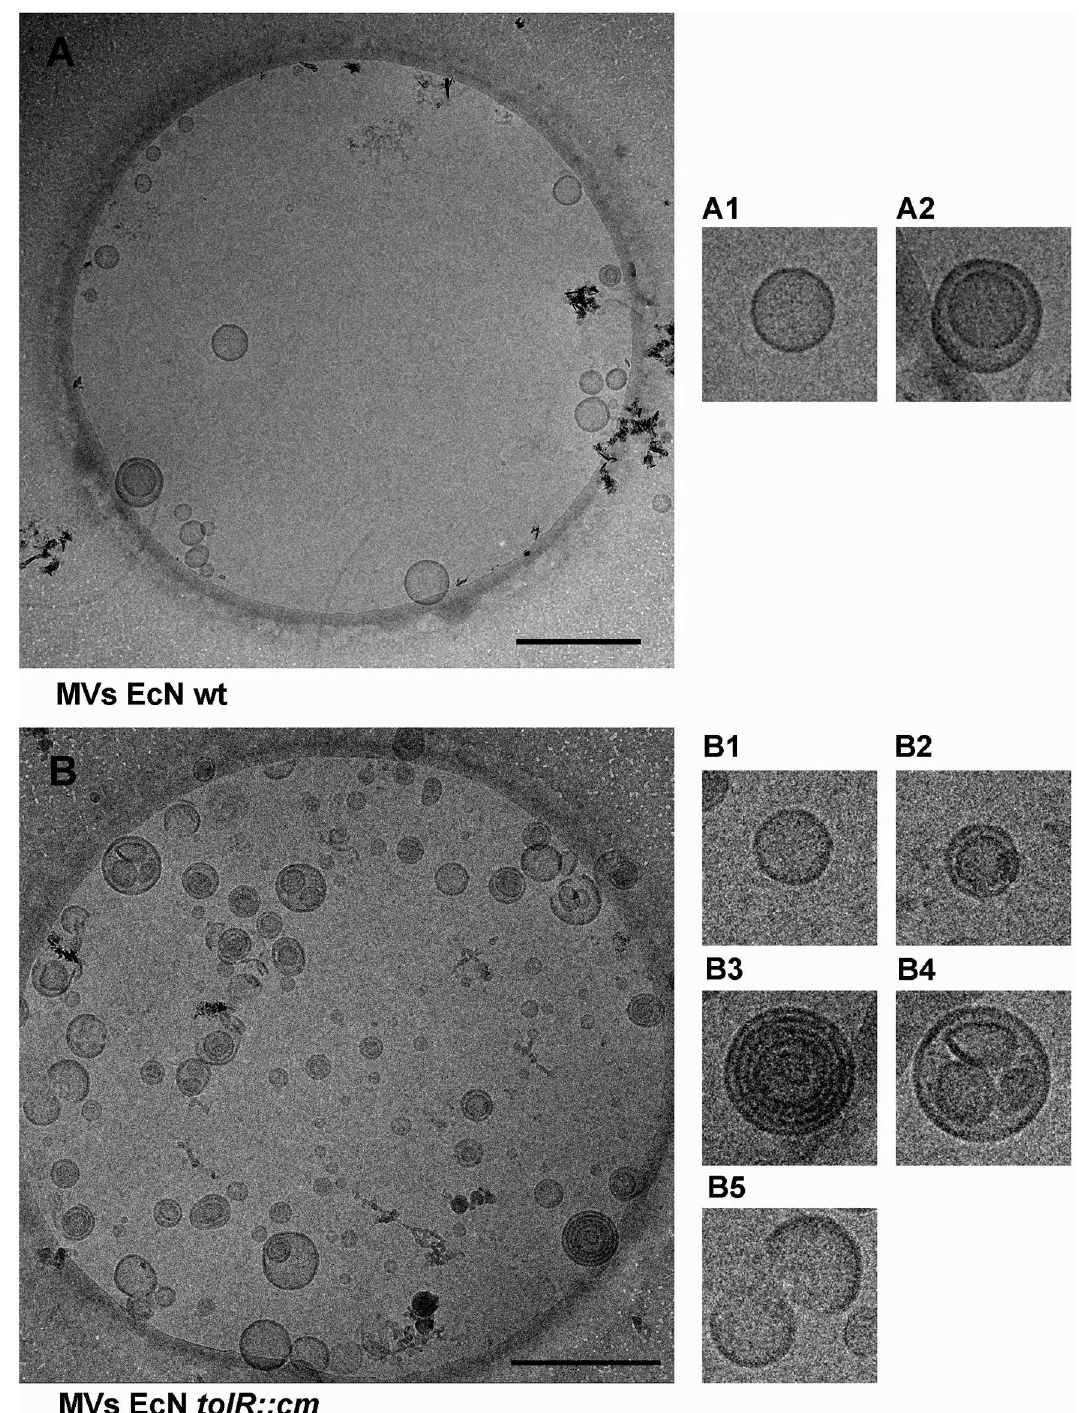
Fig 4. Isolated MVs from EcN and EcN tolR strains observed by cryo-TEM. (A) A representativeimage of EcN MVs, in which two types of MVs can be seen. The most abundant correspondto common OMVs (magnifiedview A1). A few of the recently describedMVs named O-IMVs (magnifiedin view A2) were also observed. (B) A representiveimage of EcN tolR MVs showingdifferent vesicle types. Magnifiedviews are shown on the right: (B1) common OMVs; (B2) O-IMVs; (B3) multi- layered vesicles; (B4) groupedvesicles; (B5) partially circularized membranes. Representative images of plunge-frozen MVs from two different batches of MVs isolated from each strain are shown. Scale bars: 500 nm.